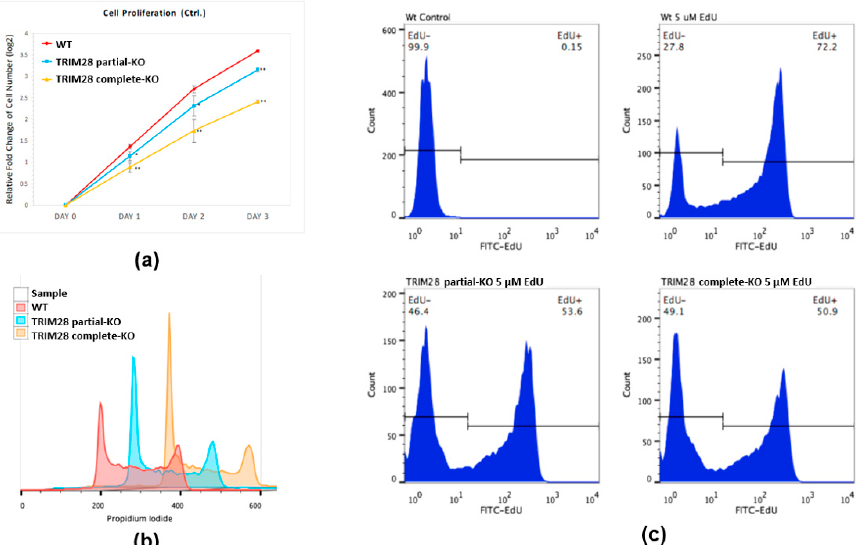
Figure 3. The expression level of TRIM28 regulates K562 cell proliferation. ( a ) The cell proliferation of WT, partial-KO and complete-KO K562 was determined by cell counting. Values are derived from an average of three independent experiments at the indicated time points. Data were normalized to day 0 (2 × 10 5 ) and used Log2-fold change as cell duplication rate. * p < 0.05; ** p < 0.01 comparison to the WT K562 cells. ( b ) The cellular DNA content of WT, partial-KO, and complete-KO K562 was analyzed by flow cytometry. ( c ) EdU labeling showing proliferation of WT, partial-KO, and complete-KO cells.